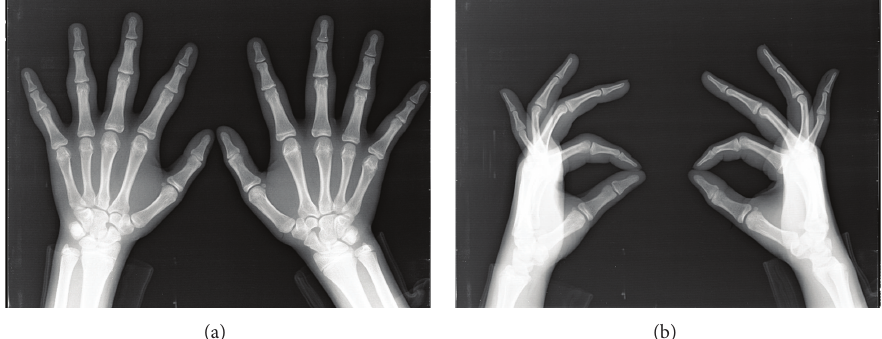
Figure 2: Plain radiograph of bilateral hands at the first examination. No bony erosive and joint destruction around the PIP joints on anteroposterior (a) and lateral (b) images.